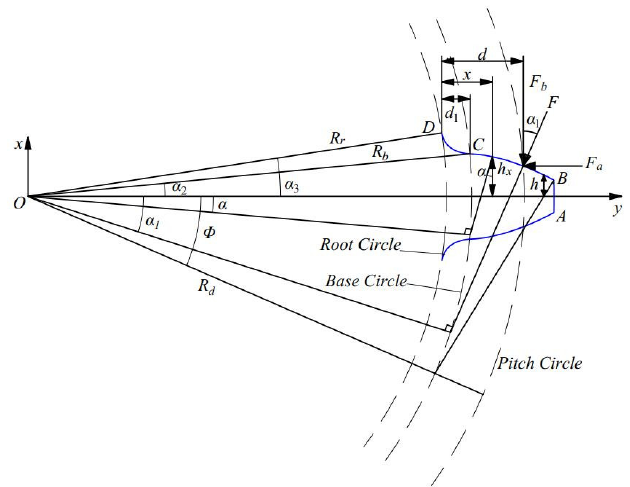
Figure 1. Geometric diagram of a gear tooth profile.